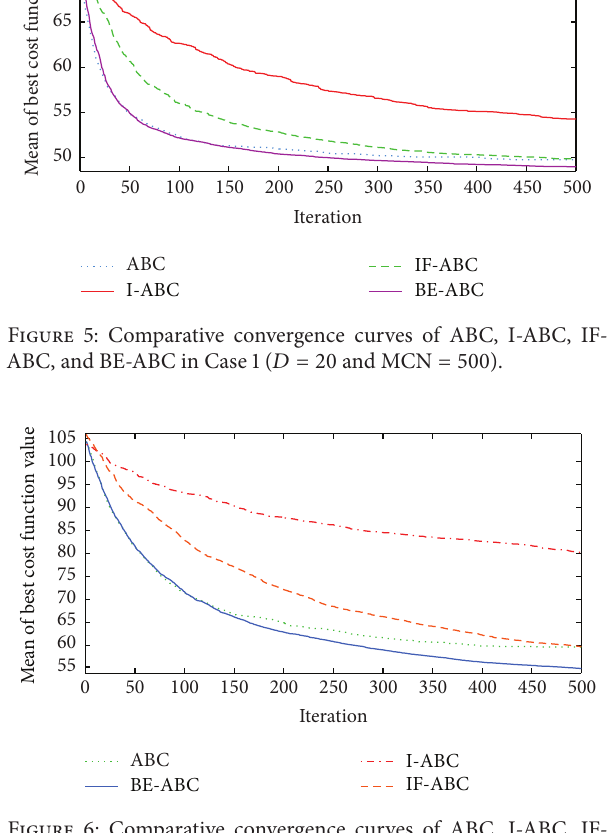
Figure 6: Comparative convergence curves of ABC, I-ABC, IF- ABC, and BE-ABC in Case 1 ( 𝐷 = 50 and MCN = 500